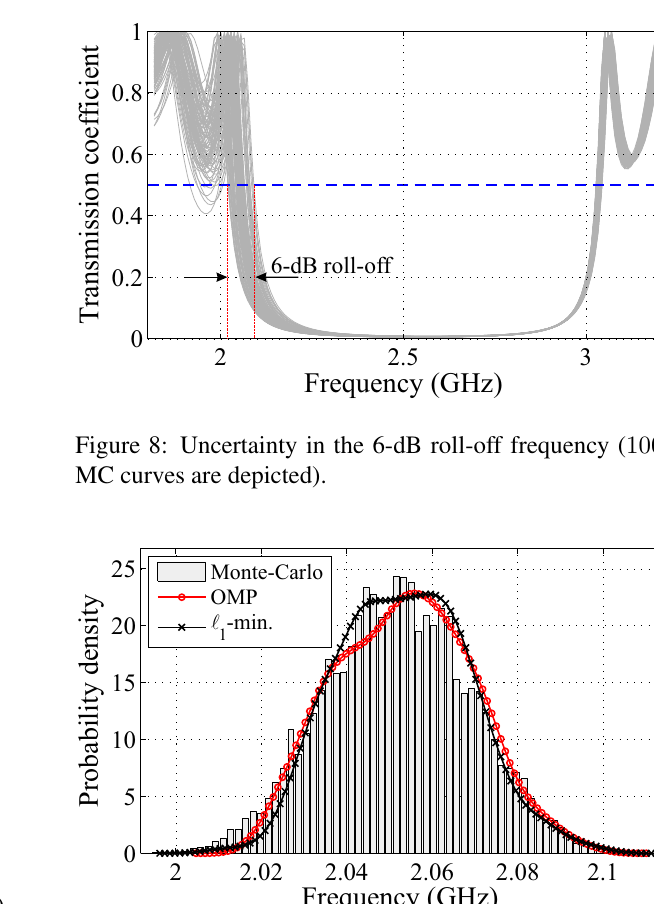
Figure 7: Magnitude of PC coefficients obtained via (a) OMP and (b) ℓ 1 -minimization.